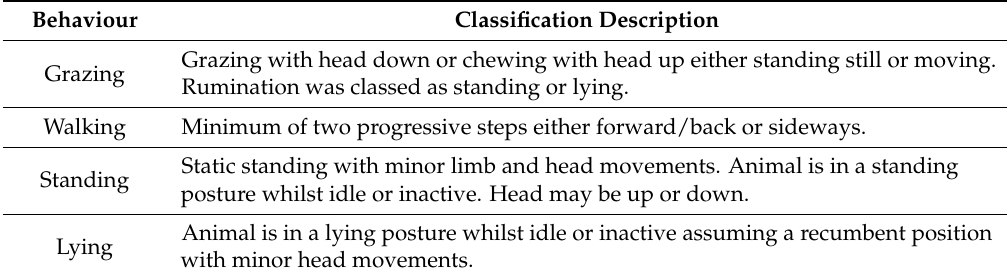
Table 1. Descriptions of the four behaviour states monitored.